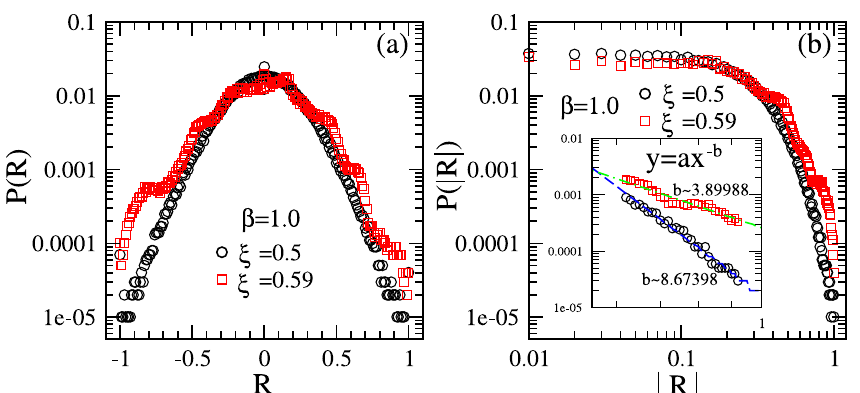
Fig 1. (a) The distributions of normalized price returns for the ratio of individuals with reference point strategies ξ = 0.5 (circles), 0.59 (squares); (b) the distributions of absolute normalized price returns for ξ = 0.5 (circles), 0.59 (squares); the inset in (b) is partial enlarged view within the range of j R j2 [0.62, 0.92]. Other parameters are: the population size N = 5001, the memory size m = 3 and m 0 = 10, the market impact β = 1, the maximal risk tolerance of reference point strategies G = 1000, the updating threshold of history-dependent strategies S = 0, the maximum max th drift of history-dependent strategies ε = 0.1, the liquidity l ¼ N , the constant a ¼ 10 , minimum and maximum shares 10 N holding k min = -1, k max = 1. Final data are obtained by averaging over 50 runs and 10 4 times after 10 5 relaxation times is uniformly distributed within the range of G in each run. The initial conditions are: an individual’s risk tolerance G i i 2 [0, G max ], an individual’s initial reference point p ref is uniformly distributed within the range of p ref 2 ½ � Pe (cid:0) a G i ; � Pe a G i � , i i initial history-dependent strategy g is distributed uniformly within the range of g 2 [0, 1], starting price P ( t = 0) is randomly chosen within the range of P 2 [0, 20], each individual’s initial number of shares k = 0, each individual’s initial wealth W i ( t = 0) = 0, each individual’s initial cash C i ( t = 0) =